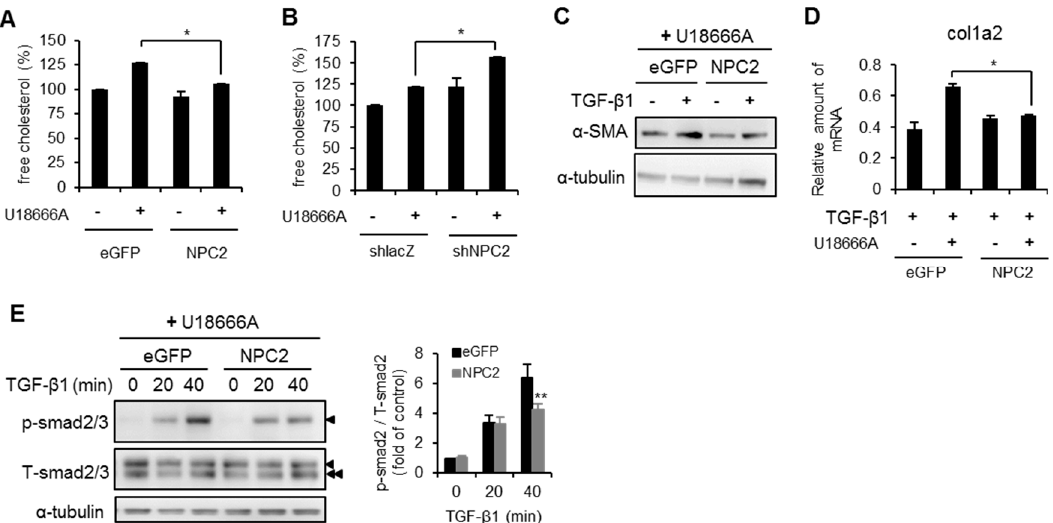
Figure 7. Overexpression of NPC2 diminishes U18666A- and TGF- β 1-induced free cholesterol accumulation and HSCs activation. ( A , B ) Different lentiviruses infected stable cells were pretreated with or without 1 µM U18666A overnight and then subjected to intracellular free cholesterol quantification; ( C – E ) eGFP- and NPC2-overexpressed LX2 cells were pretreated with 1 µM U18666A overnight and then treated with 20 ng/mL TGF- β 1. Cell lysates were immunoblotted to detect α -SMA ( C ) and Smad2 phosphorylation ( ► , Smad2, ►► , Smad3) ( E ). mRNA expression of Col1a2 was analyzed using Q-PCR ( D ). * p < 0.05. ** p < 0.01 vs. eGFP. Each experiment was performed in three independent replicates. A similar phenomenon was observed. Therefore, the representative data was shown in the figure.